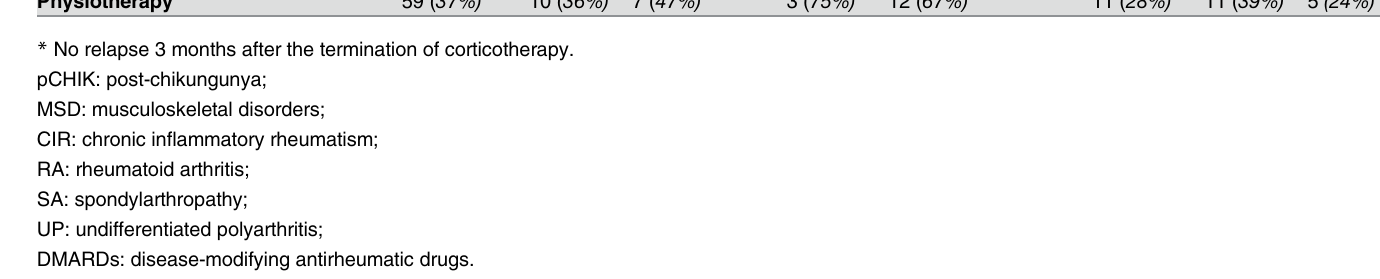
appropriate urate-lowering therapy, as the final diagnosis for their worsening condition was gout. For the 2 patients with untreated chronic viral hepatitis (B and C, one case each), hydroxy- chloroquine was ineffective in relieving joint inflammation, and consequently, sequential short chloroquine, 3 had to complete their treatment with immune-modulating biologic agents. pCHIK-RA) and was associated with the highest prevalence of osteoarticular damage, require- ment for braces, and functional consequences (Table 4).